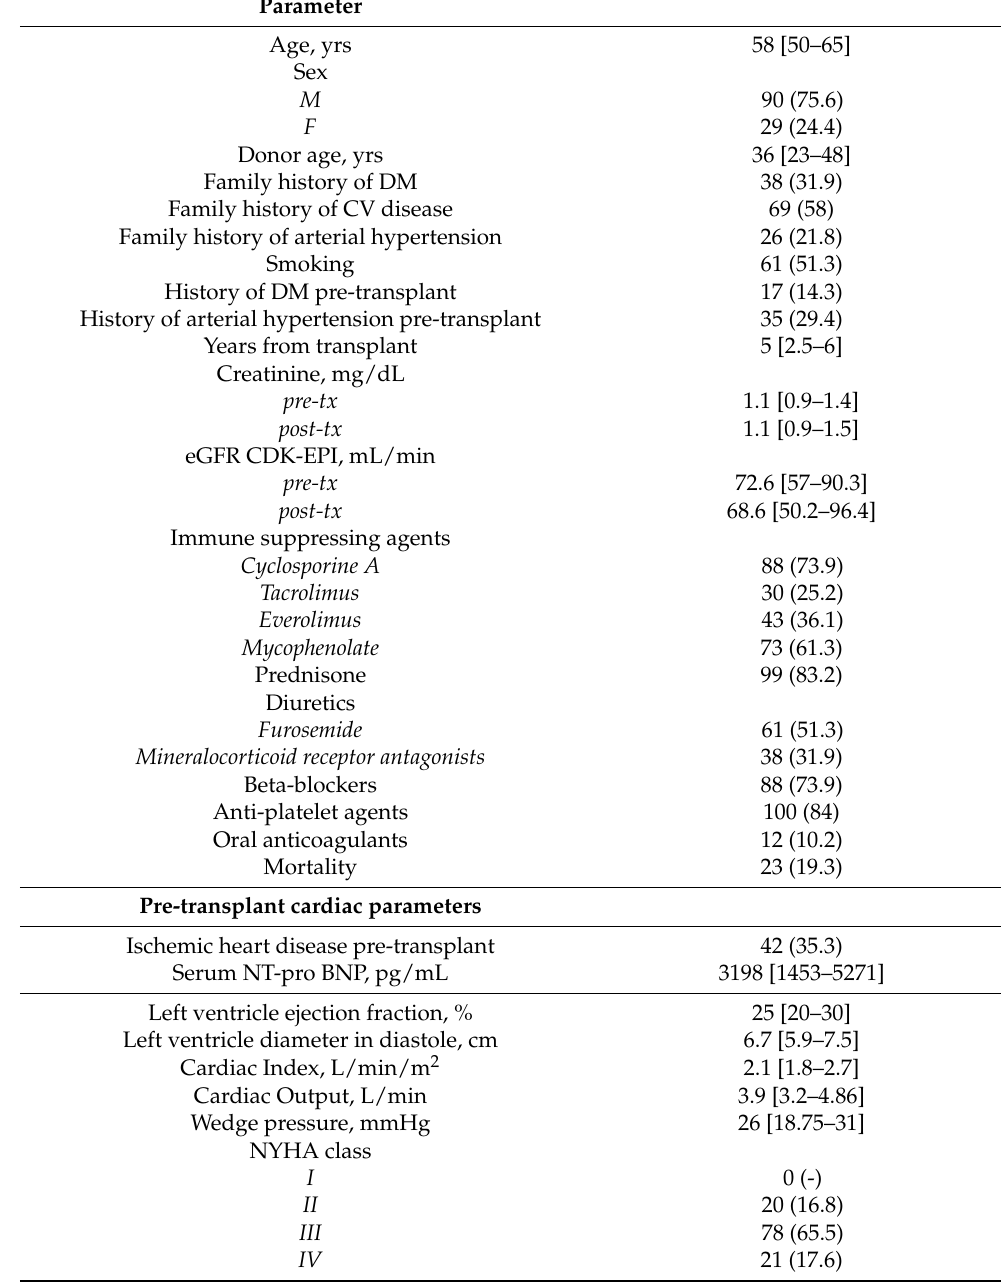
Table 1. Clinical features of the study cohort (N =